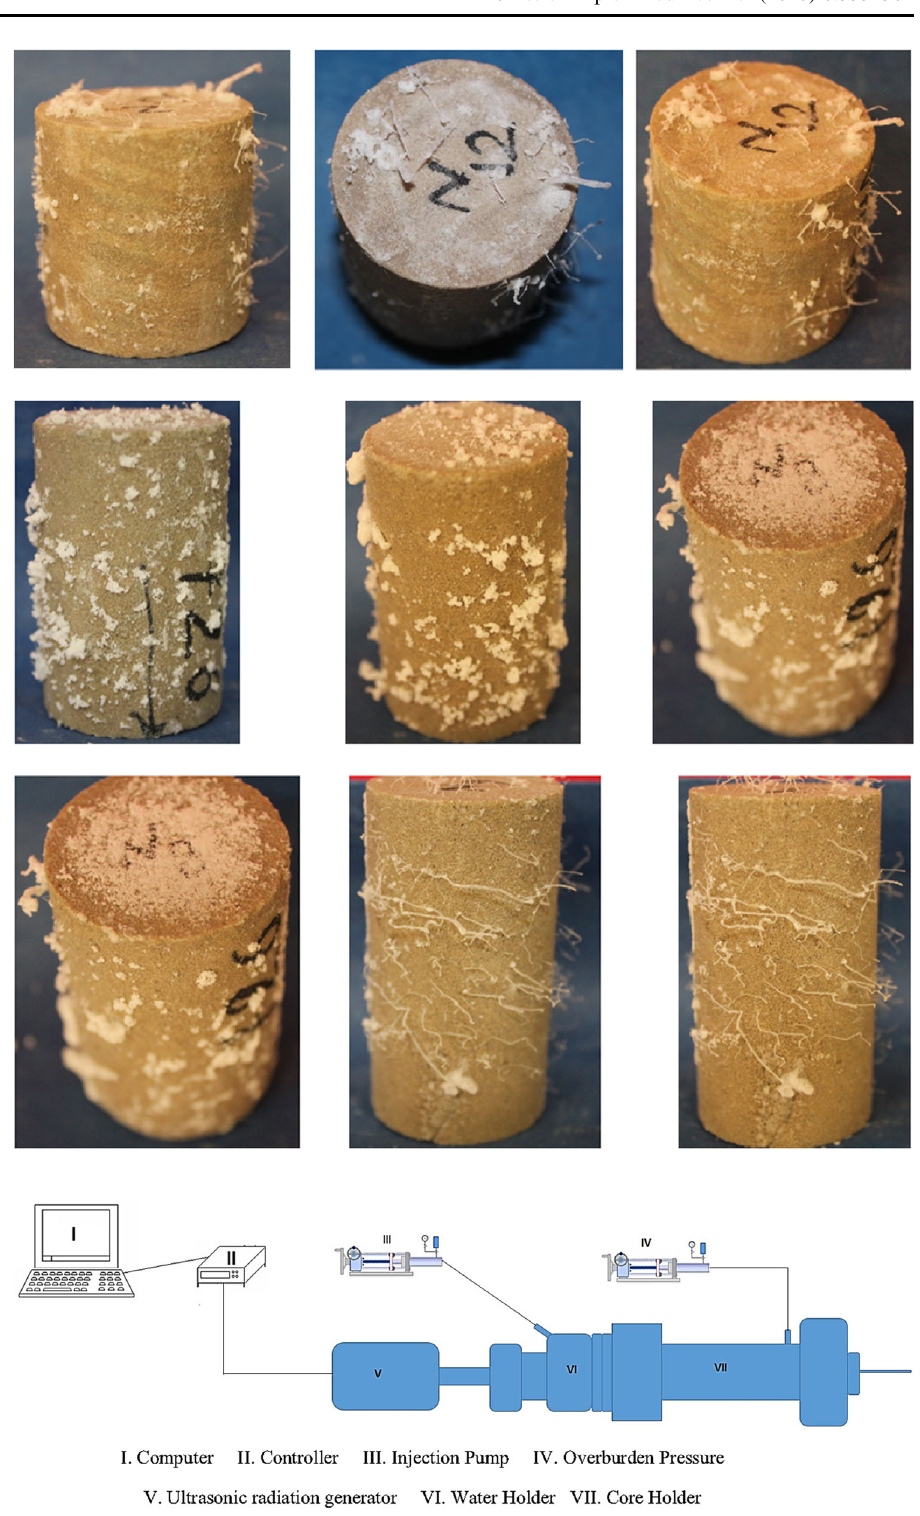
Fig. 2 Schematic of flooding apparatus equipped with ultrasonic wave. I computer, II controller, III injection pump, IV overburden